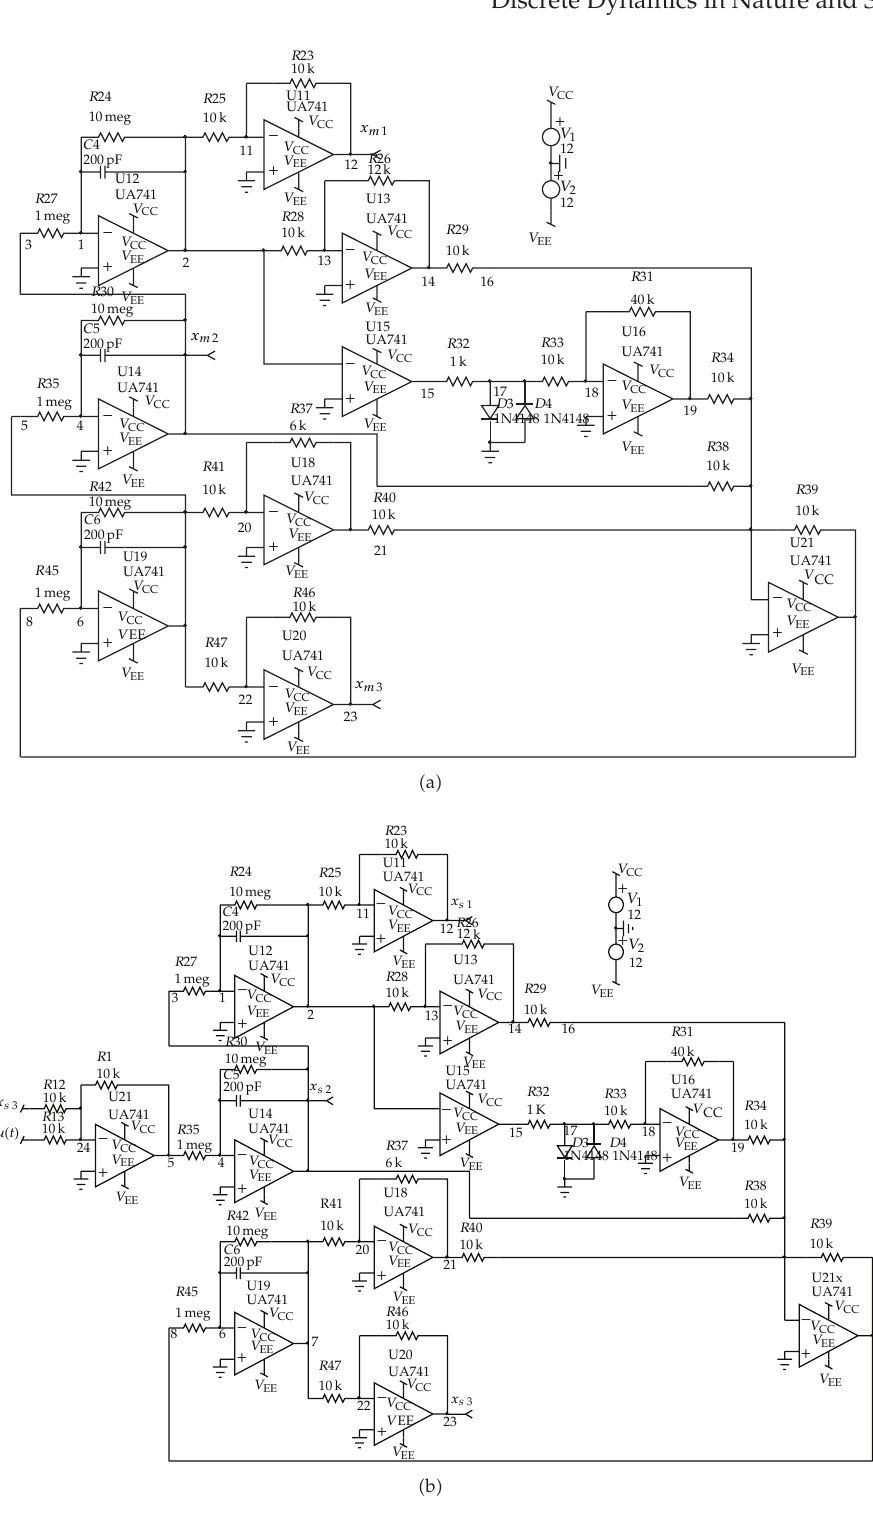
Figure 5: Electronic implementations of Sprott circuits. (cid:2) a (cid:3) master system; (cid:2) b (cid:3) slave